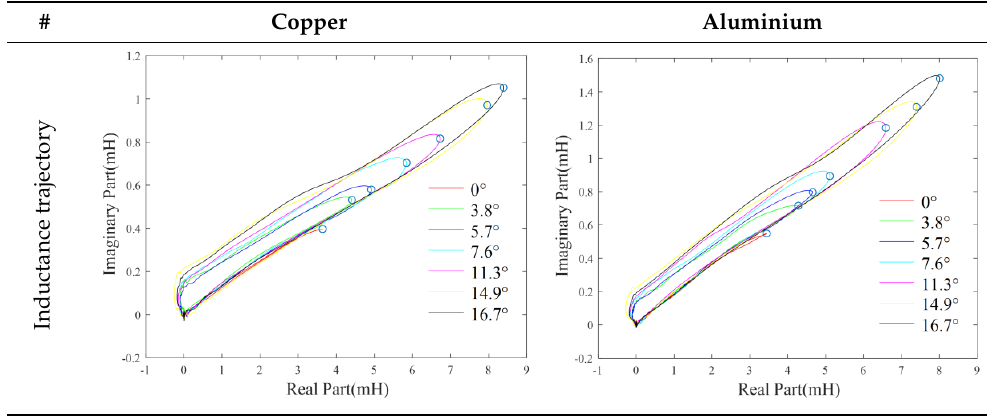
Table 2. Approximate linear relationship between the endpoint of inductance trajectory (marked by circles) and tilt angles [53].